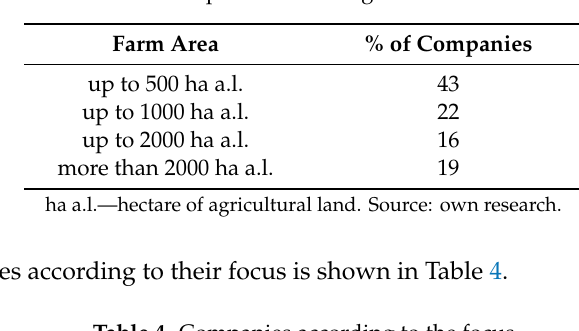
Table 4. Companies according to the